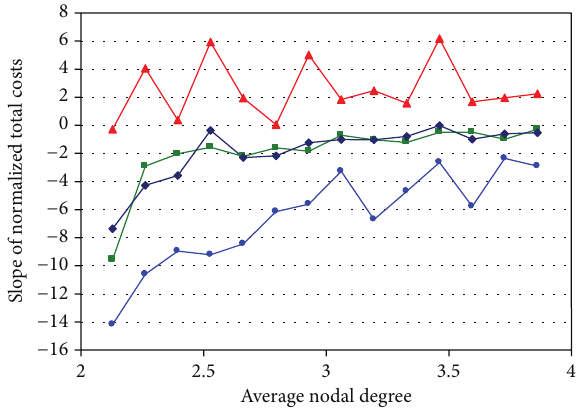
Figure 11: Slope of normalized SBPP JCA total capacity costs.